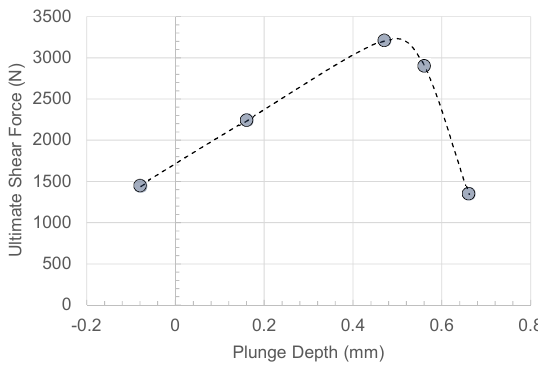
Figure 34. Influence of the penetration depth on the ultimate shear force (data from [77]).